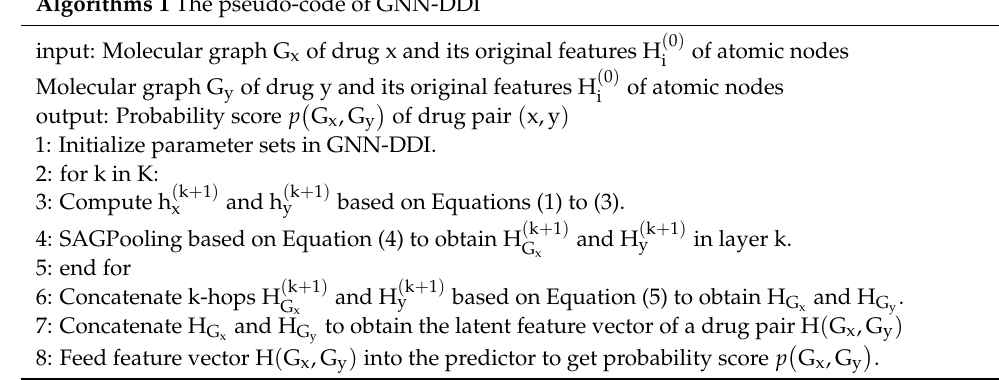
Figure 3. Overall framework of GNN-DDI. ( A ) drug feature extractor. The five-layer GAT networks are built to encode the molecular structure graph of each drug into its feature vectors H (cid:2919) (h (cid:2919)(cid:2869)((cid:3038)) , h (cid:2919)(cid:2870)((cid:2921)) ,… , h (cid:2919)(cid:2926)((cid:2921)) ) (cid:2904) , to capture topological properties especially chemical functional groups within the whole chemical structure graph, which are critical in drug interactions. In addition, the atomic nodes feature vectors H (cid:2919)((cid:2921)) in the molecular graph output from each layer are transformed to drug feature H by SAGPooling in each layer, and those drug features H are concatenated together as final drug feature vector Z G . ( B ) DDI predictor. Concatenating two drug latent features Z G and Z G to feed into a MLP for implementing the prediction task. Algorithms 1 The pseudo-code of GNN-DDI.